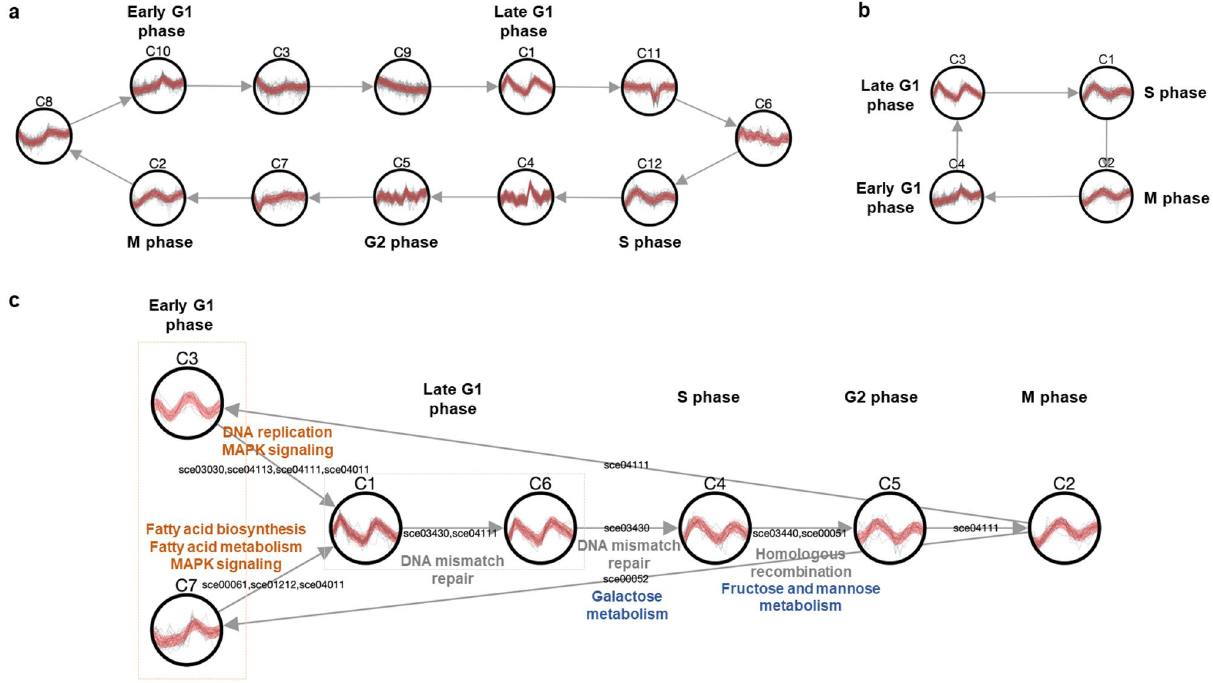
Figure 3. Cluster network of yeast cell cycle dataset by TRACS using ( a ) DEGs ( P -value > 0.05), ( b ) remaining DEGs after filtering clusters enriched with cell cycle pathway (sce04111) from the result of ( a ), and ( c ) 220 labelled genes. In ( c ), repetitive pathway (cell cycle pathway, sce04111) is